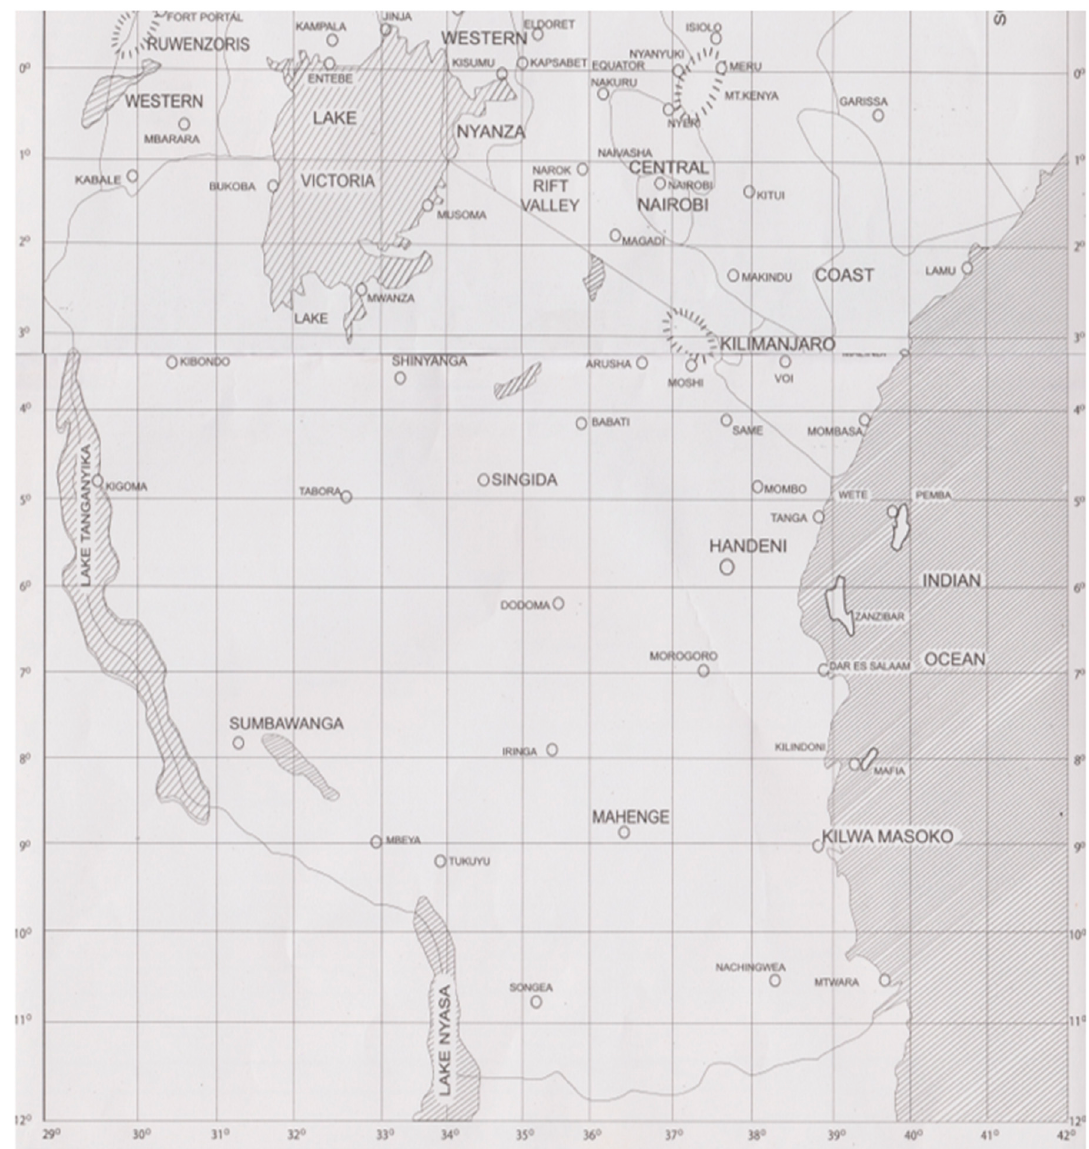
Figure 4. The Tanzania Meteorological Agency (TMA)’s station network. The circles indicate the locations of both automatic and manned stations. (Image source: Tanzania Meteorological Authority).